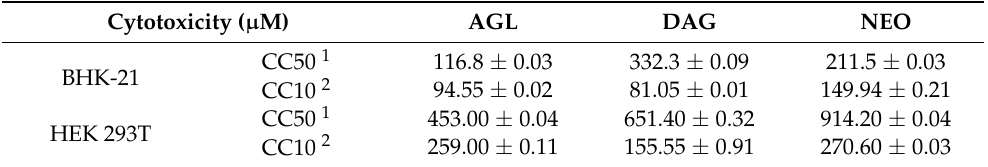
Table 1. Cytotoxicity of andrographolide (AGL), deoxyandrographolide (DAG), and neoandro- grapholide (NEO) in BHK-21 and HEK 293 T cells.